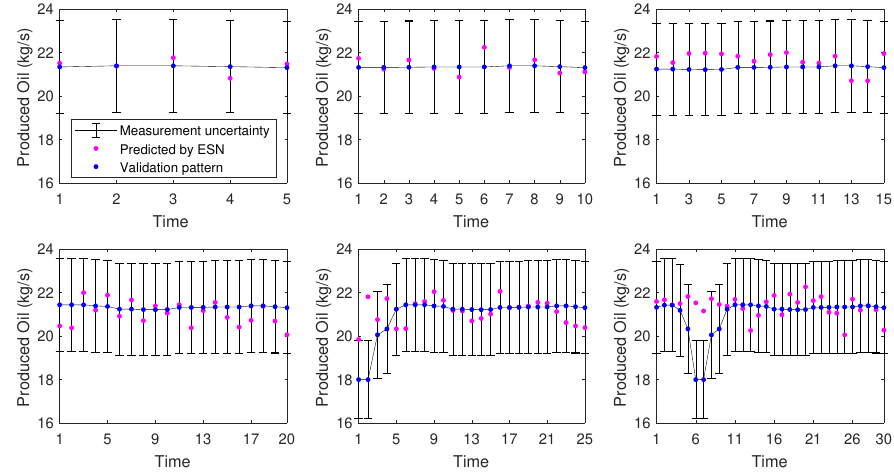
Figure 11. Prediction in a time horizon—6 months time series.